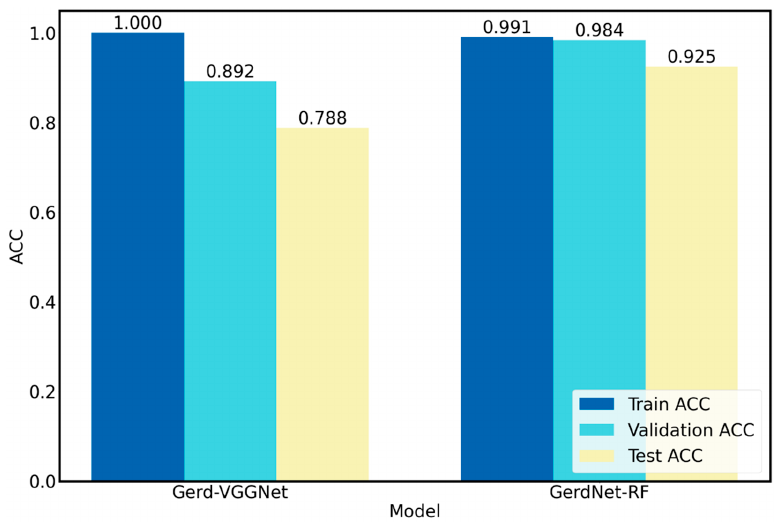
Figure 8. Comparison of performance of Gerd-VGGNet with proposed GerdNet-RF.